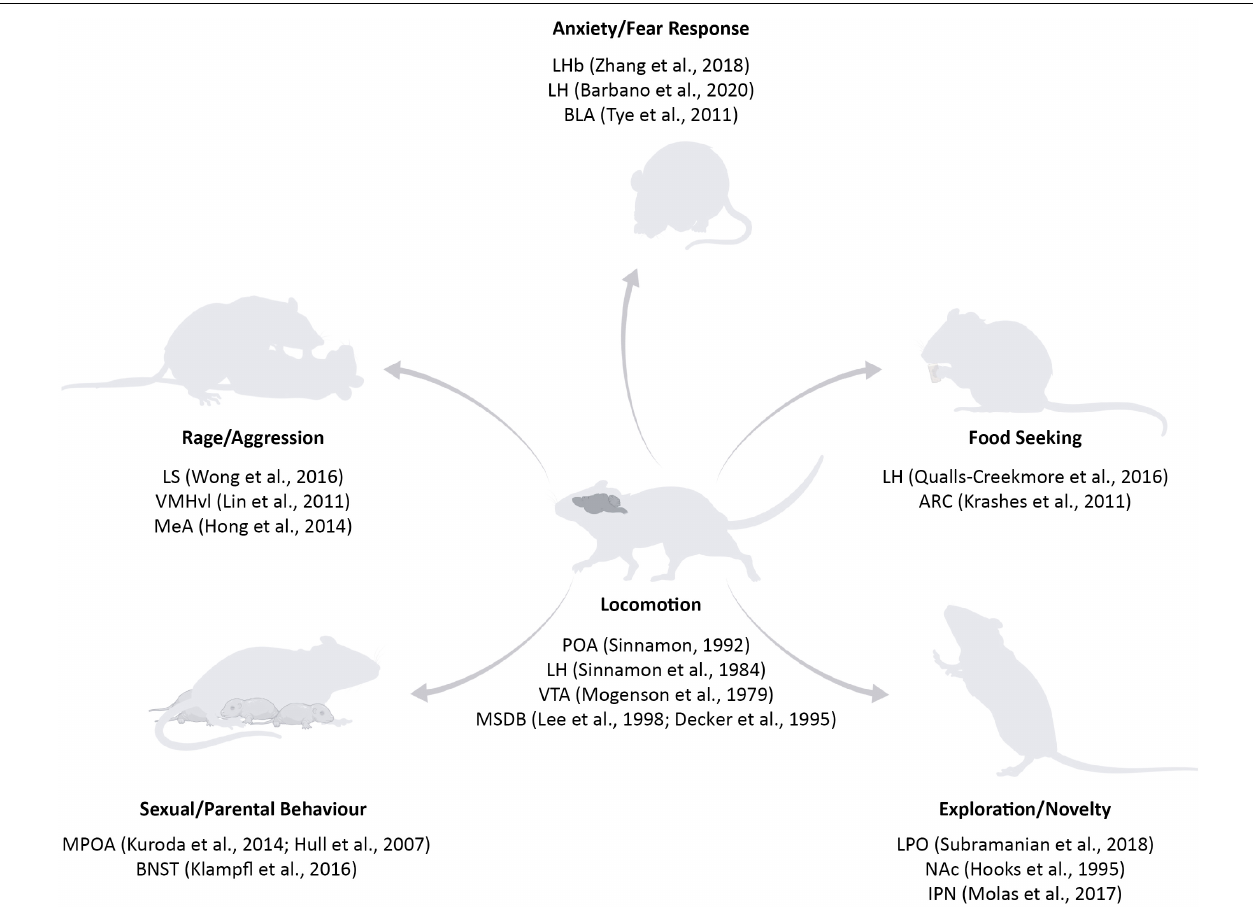
FIGURE 1 | Subcortical structures involved in locomotion and in different motivations to move. Key areas in the basal forebrain, hypothalamic, and midbrain structures have been classically linked to locomotion (for example, POA, LH, VTA, and MSDB) (Mogenson et al., 1979; Sinnamon et al., 1984; Lee et al., 1988; Sinnamon, 1992; Decker et al., 1995). With the rise of new tools, it was possible to specify the contribution of specific areas on distinct reasons to move: fear responses are controlled by BLA, LHb, and LH (Tye et al., 2011; Zhang et al., 2018; Barbano et al., 2020); food seeking centres have been found in the LH and